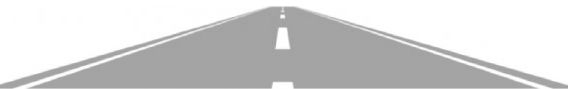
Figure 8: Lane perspective results.